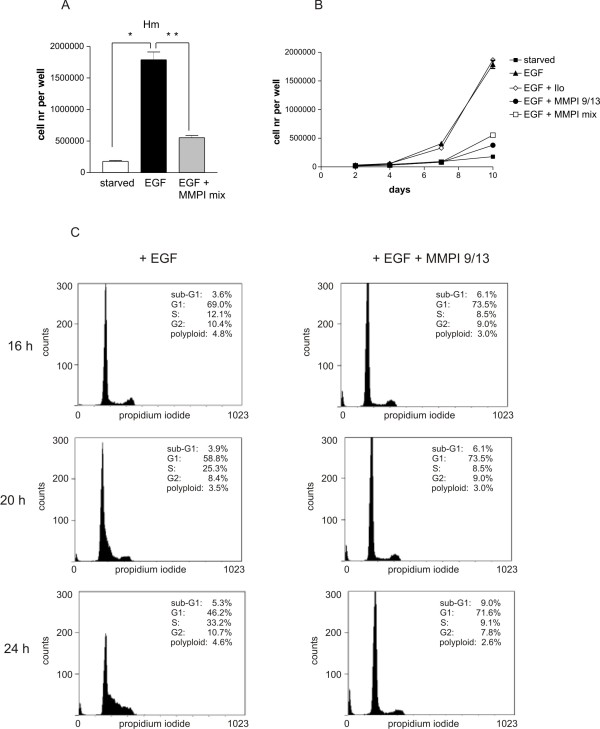
MMP inhibition results in strongly reduced proliferation of melan-a Hm cells. A: Hm cells were starved for two days in presence of 1.5% dialyzed FCS and were then stimulated by the addition of 100 ng/ml EGF, either in absence or presence of the MMP inhibitor mix containing MMP inhibitors MMPI 9/13 and Ilomastat. The number of cells per well after ten days of treatment is indicated. *: p < 0.05; **: p < 0.0001. B: Starved Hm cells were stimulated with EGF in absence or presence of Ilomastat, MMP9/13 inhibitor or a combination of both. Cell proliferation was measured after 2, 4, 6, 8 and 10 days. C: Cells were starved as above and were incubated with EGF in absence or presence of the MMP inhibitor 9/13. Their cell cycle state was monitored after 16, 20 and 24 h. The first accumulation of cells into S-phase is seen after 20 h. The assay was performed three times, and a representative example is shown.